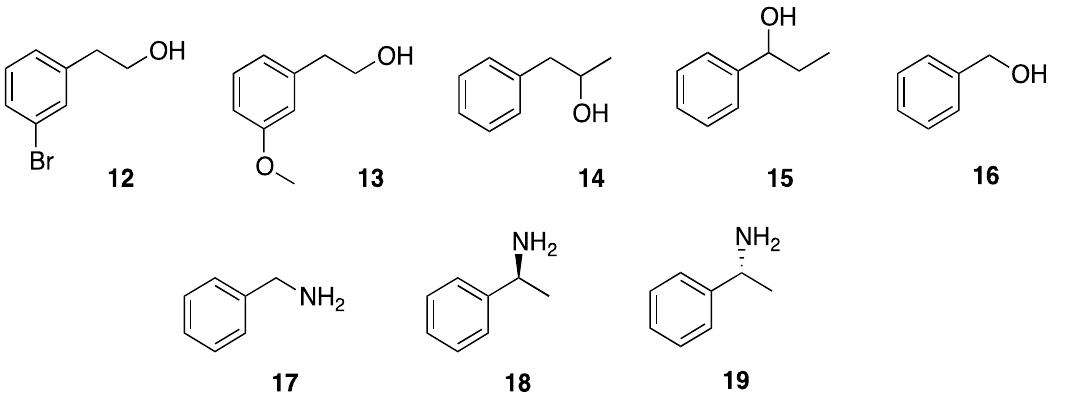
Scheme 4. Alcohols and amines used as substrates in KLEST-3S-catalysed acetylation reaction.